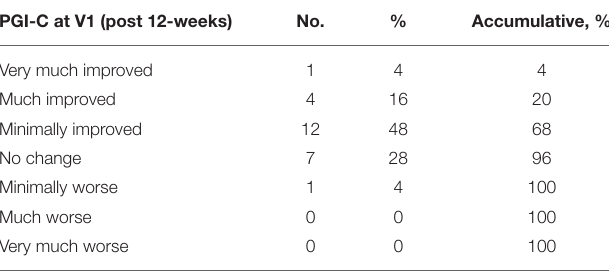
TABLE 6 | The PS128 intervention improves patient global impression of change scores. PGI-C at V1 (post 12-weeks) No. % Accumulative, % Very much improved